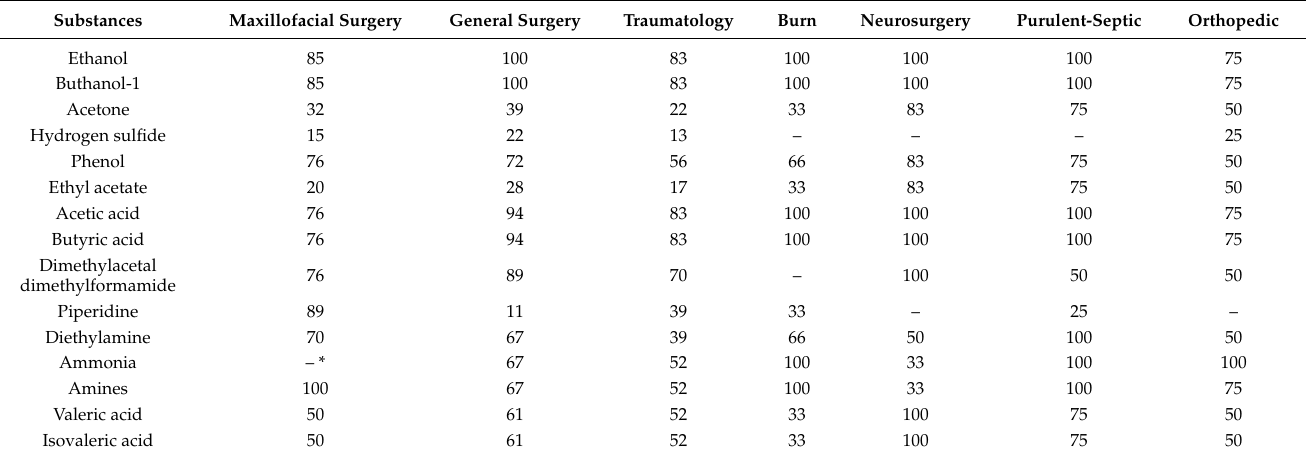
Table 3. Identified substances in the EGP of urine samples from patients in departments of the children’s hospital (% of the total number of